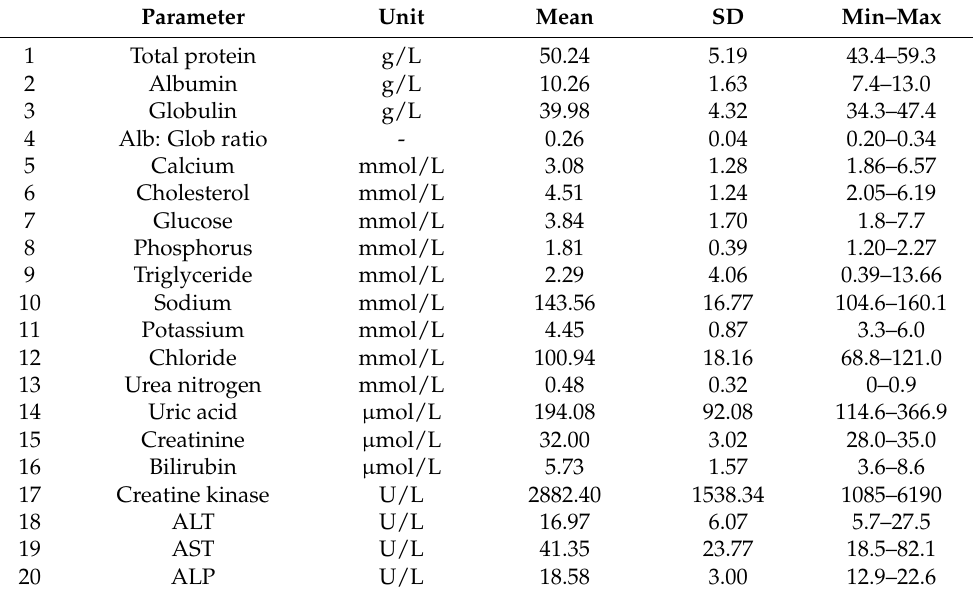
Table 4. Serum Biochemical Values of Male and Female False Gharial ( n = 10). For each parameter the mean and the standard deviation (SD), as well as the minimum (Min) and maximum (Max) range are